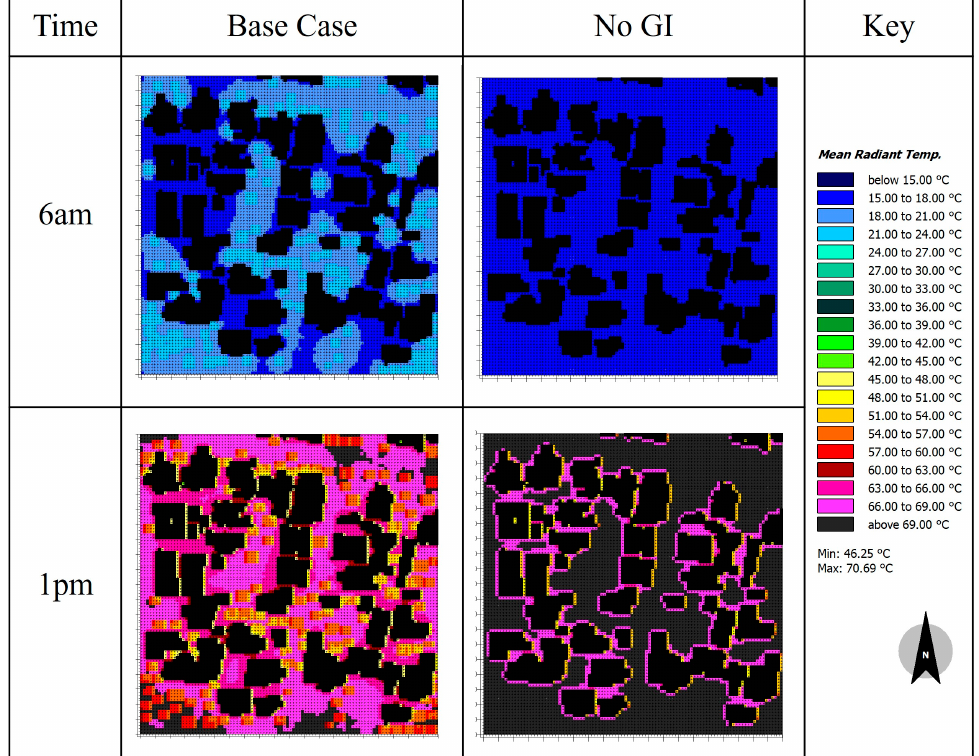
Figure 12. Spatial MRT variations at location 3 for 6 a.m. and 1 p.m.